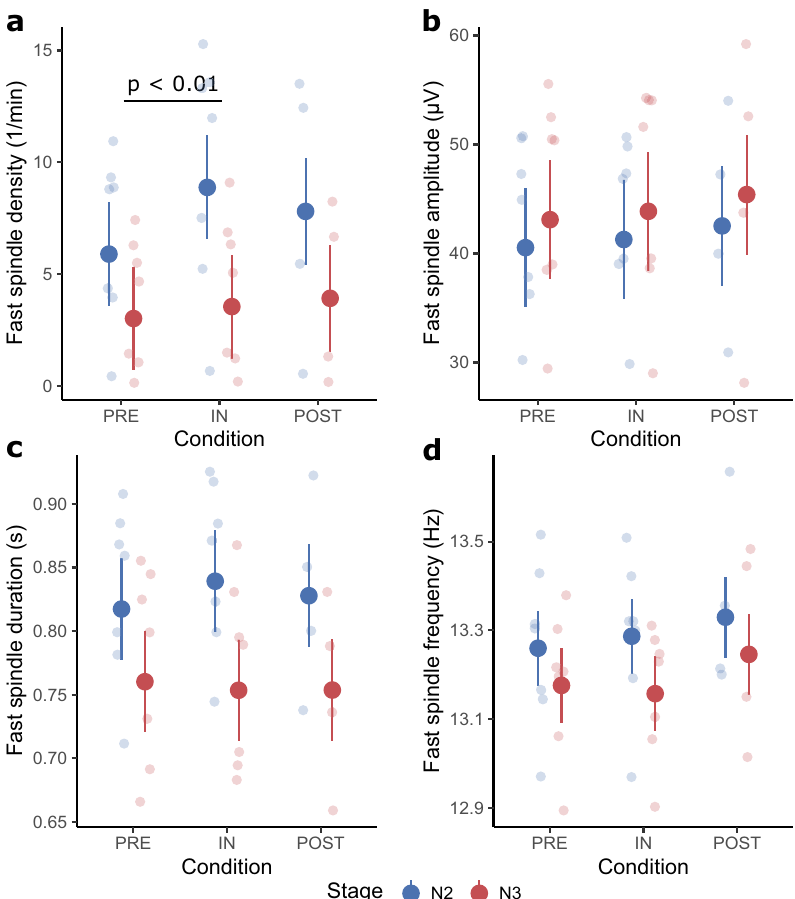
Fig. 2 Fast spindle characteristics. Large dots represent the estimated marginal means (± standard error) of each condition separated by sleep stage. The smaller dots in the background are individual data points in the respective condition and sleep stage. Signi fi cant differences (except between stages) are indicated by a black bar with an annotation stating the p -value. a Shows a signi fi cant difference of fast spindle densities between pre fl ight and in fl ight. b Shows the fast spindle amplitude. c Shows the fast spindle duration. d Shows the fast spindle Melatonin ( F (1,26.05) = 1.24, p = 0.28) nor the Condition × Stage interaction ( F (2,26) = 0.06, p = 0.94). For slow spindle duration (Fig. 3c) only the factor Stage was signi fi cant ( F (1,26) = 60.71, p < 0.01; Supplementary Table 14). All other factors did not signi fi cantly modulate the duration (Condi- tion: F (2,26) = 0.60, p = 0.56, Condition × Stage: F (2,26) = 0.16, p = 0.85, Melatonin: F (1,26.10) = 1.35, p = 0.26) Slow spindle frequency (Fig. 3d) was signi fi cantly affected by Condition ( F (2,26) = 17.31, p < 0.01), while all other factors had no signi fi cant effect (Stage: F (1,26) = 0.19, p = 0.67; Melatonin: F (1,26.07) = 0.07, p = 0.80; Condition × Stage: F (2,26) = 0.28, p = 0.76). Post hoc results revealed a slow spindle shift towards higher frequencies by 0.17 ± 0.03 Hz in fl ight compared to pre fl ight (Table 1). Upon return to Earth, the slow spindle frequency reverted to the pre fl ight baseline (Table 1). Additionally, we repeated the same analysis for sleep spindles detected across the entire spindle band from 9 to 15 Hz (Fig. 1a) to make our fi ndings readily comparable to studies that focused on overall sleep spindles and did not distinguish fast and slow spindle types. Overall sleep spindle density (Fig. 4a) did not signi fi cantly differ between conditions ( F (2,26) = 0.01, p = 0.99) and was not affected by the Condition × Stage interaction ( F (2,26) = 0.94, p = 0.40). Stage turned out to have a signi fi cant effect on sleep spindle density ( F (1,26) = 109.91, p < 0.01; Supplementary Table 20)